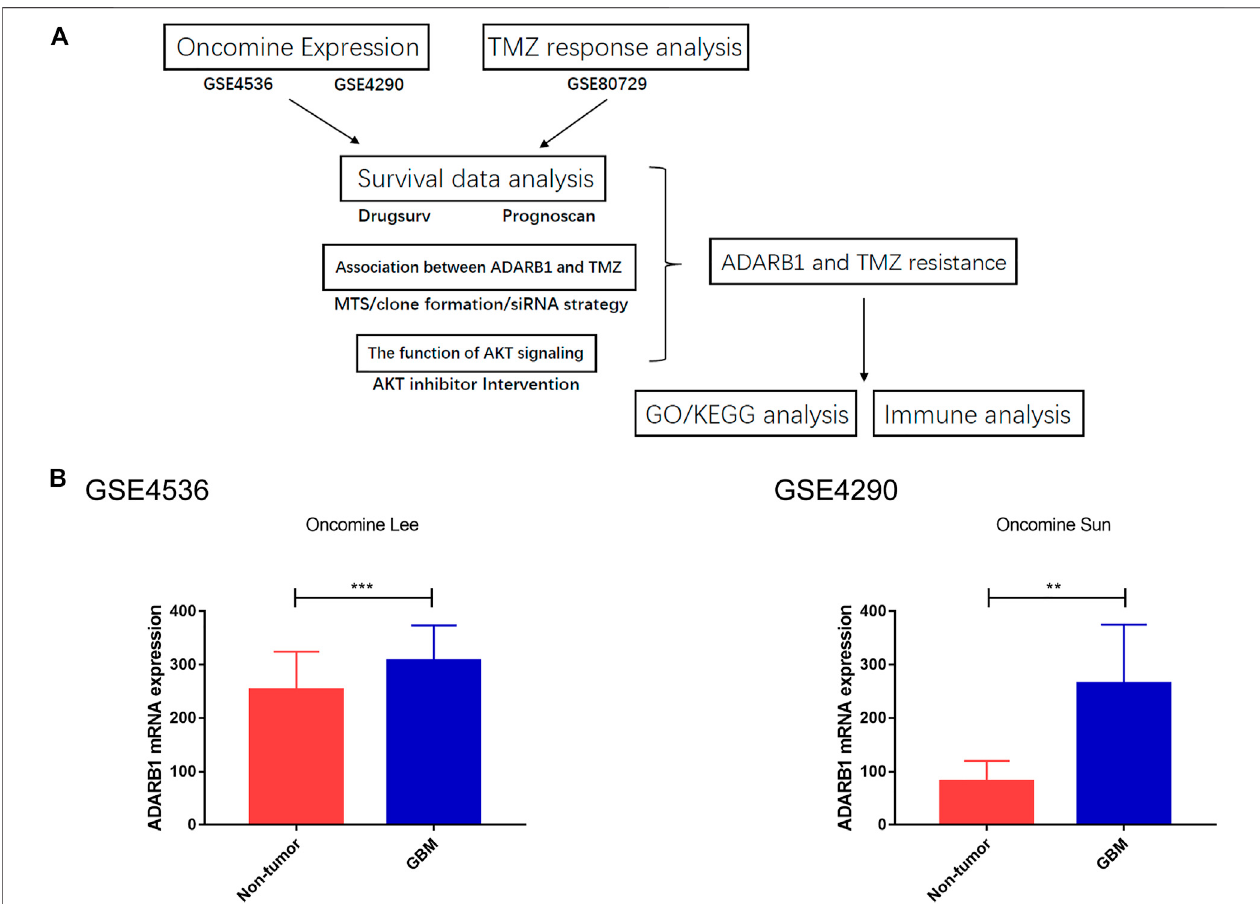
FIGURE 1 | ADARB1 upregulated in GBM. (A) The fl owchart of the whole analysis process. (B) The mRNA expression of ADARB1 in GBM and noncancerous tissueswereanalyzedusingtheOncominedatabase.Dataperformedwithmean±SDweresubjectedtoStudent ’ st-test. (C) ThemRNAexpressionofADARB1inGBM cells treated with DMSO or TMZ. (D – F) The relationship between ADARB1 expression and OS, analyzed from GSE13041, GSE4412 and GSE4271 databases. In GSE13041, thered line refers tothe high expression level of ADARB1 and thegreen linerefers tothe low expression level of ADARB1. In GSE4412 and GSE4271, theredlinereferstothehighexpressionlevelofADARB1andthebluelinereferstothelowexpressionlevelofADARB1.TheKaplan-Meiercurveswereextrapolatedfrom GBM patients underwent